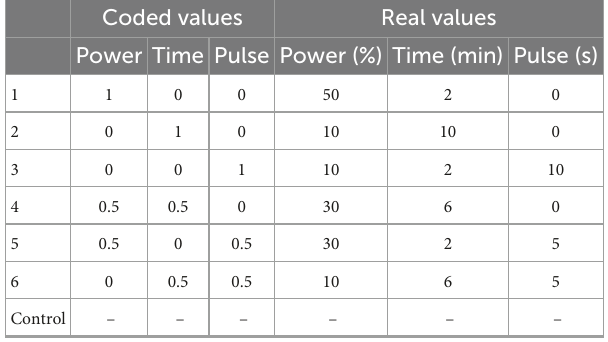
TABLE 1 US treatments tested on L. plantarum and Bifidobacterium